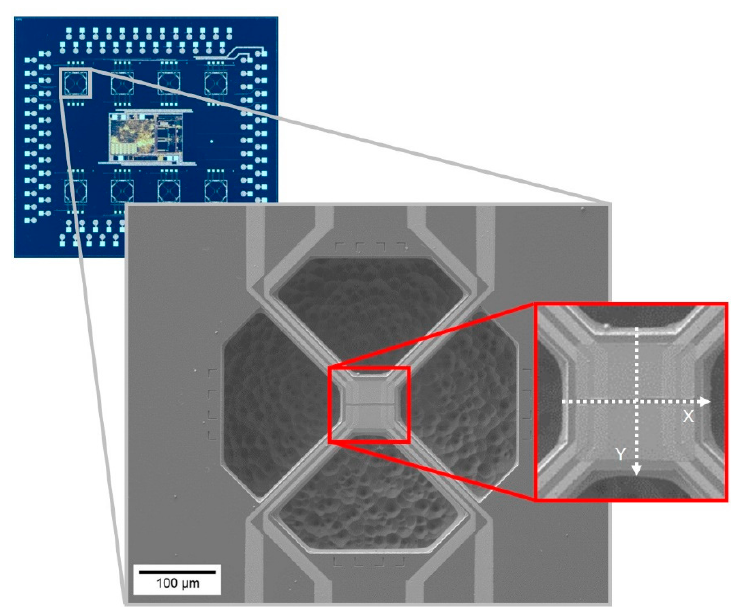
Figure 1. Fully processed CMOS chip with eight µ hps, including magnification of a single µ hp. The position and direction of the X and Y Raman line scans with respect to the µ hp are indicated in the magnified view. Line scan X is carried out in the narrow gap perpendicular to the electrical contacts (visible as light grey color). In the displayed µ hp a metal oxide layer was also deposited. This was not the case for the µ hp measured in this work.